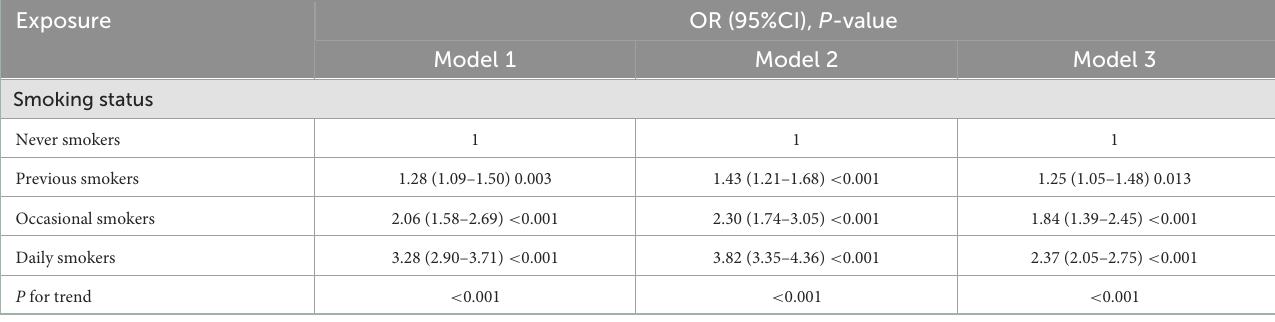
TABLE 3 Associations of smoking status with clinically relevant depressive symptoms among adults ( n = 16,724) in NHANES (2005–2018).